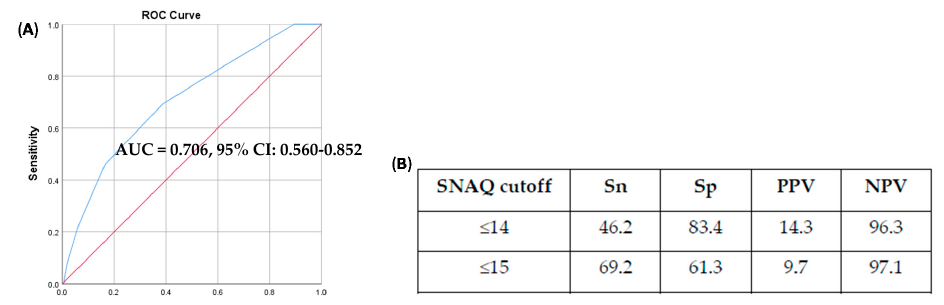
Figure 1. Receiver operating characteristic (ROC) curve ( A ) and derivation of simplified nutritional